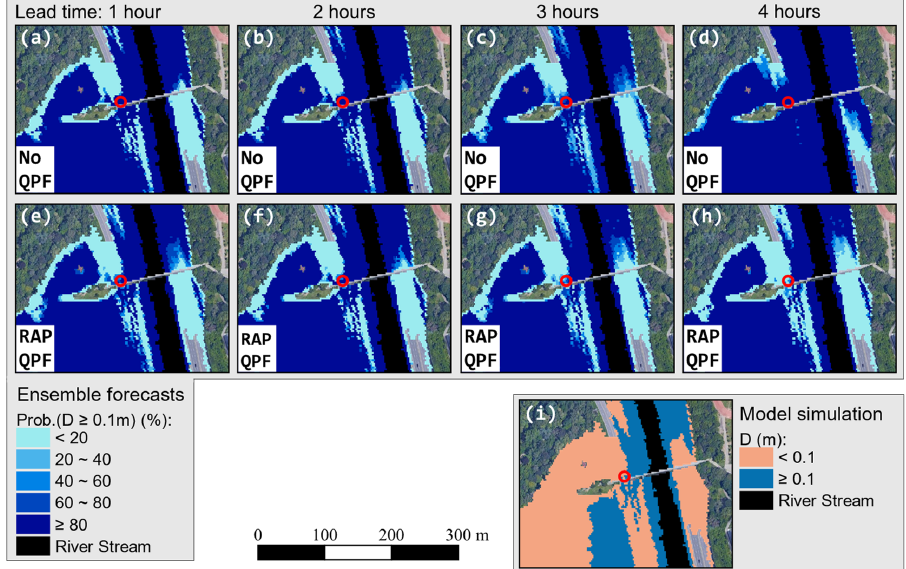
Figure 17. ( a – i ) Same as Figure 16, but for POI 2 (red circle in the maps).